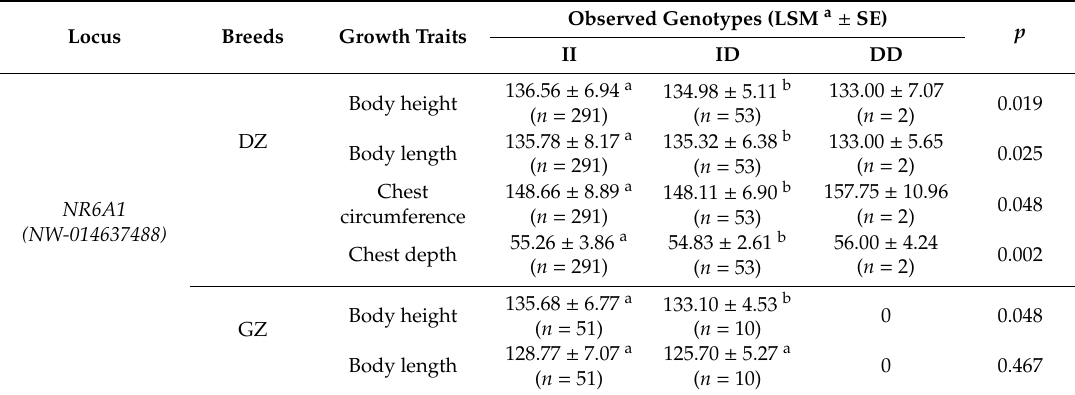
Table 3. Relationship between the 13 bp deletion locus of the donkey NR6A1 gene and growth traits with the same genotype (II, ID, and DD genotypes,